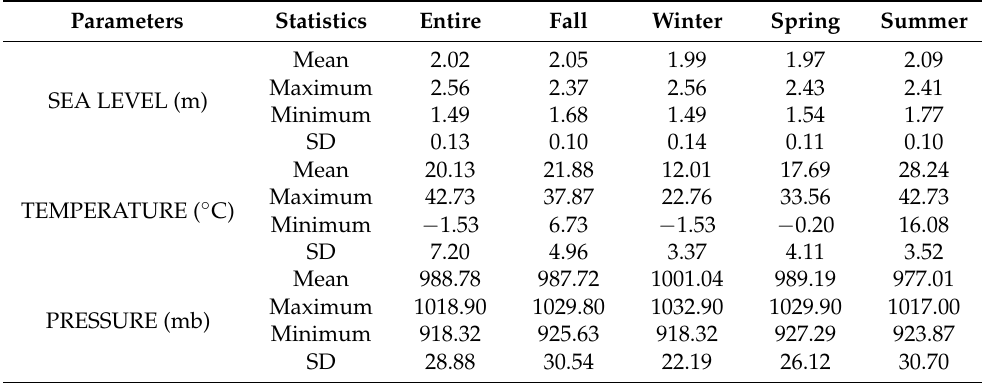
Table 1. Descriptive statistics of observed